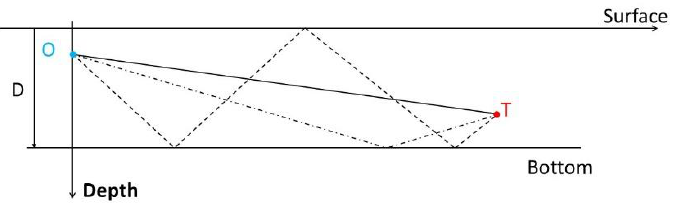
Figure 2. Three examples of ray paths: the solid line represents the direct path ( δ , n B , n S ) = (+ 1,0,0 ) , the dashed-dotted line represents the bottom reflected path ( δ , n B , n S ) = (+ 1,1,0 ) , and the dashed line represents the bottom-surface-bottom reflected path ( δ , n B , n S ) = (+ 1,2,1 ) .